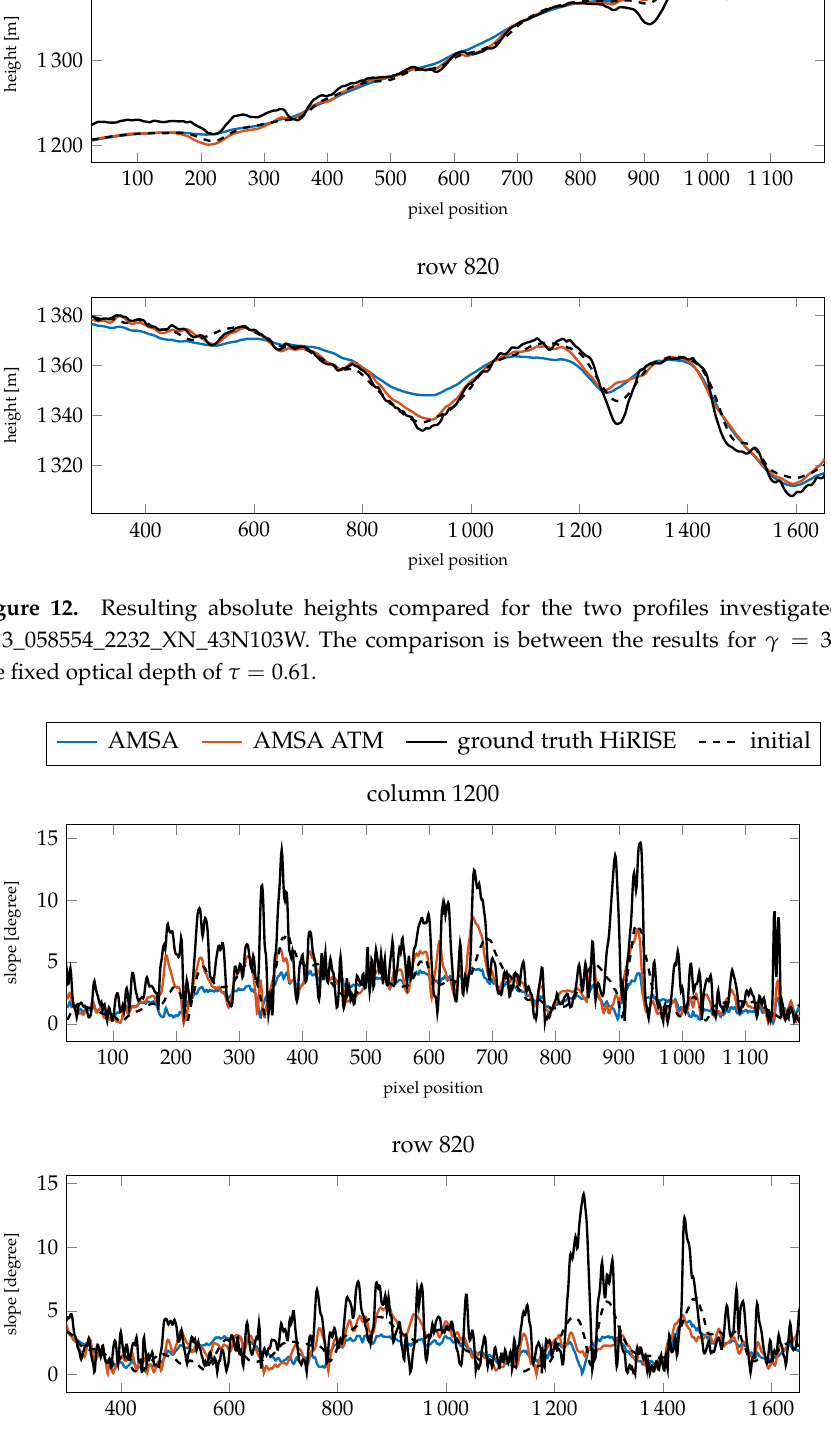
Figure 13. Resulting slopes compared for the two profiles investigated for image K13_058554_2232_XN_43N103W ( γ = 3